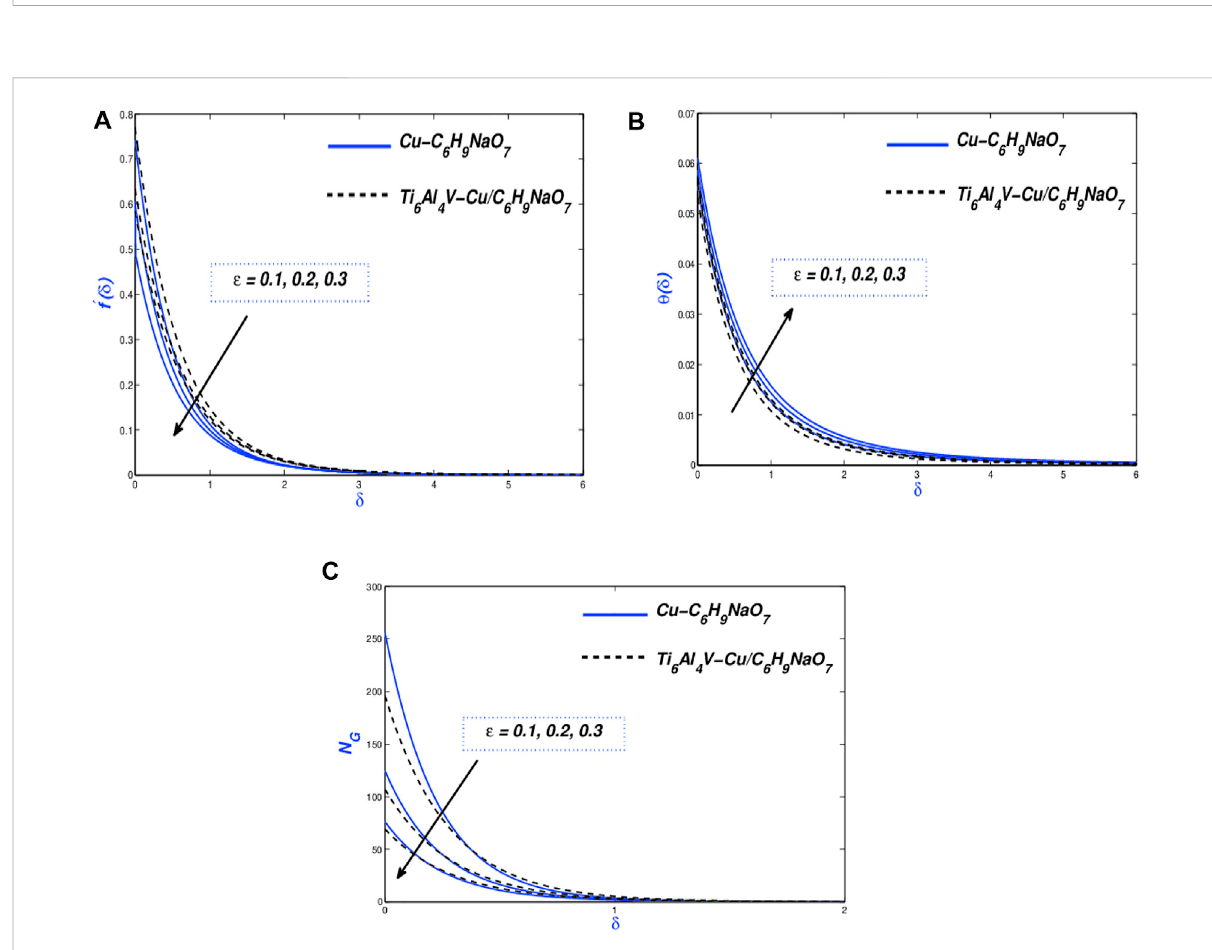
FIGURE 9 (A) f ′ ( δ ) , (B) θ ( δ ) , and (C) N G with diverse ε